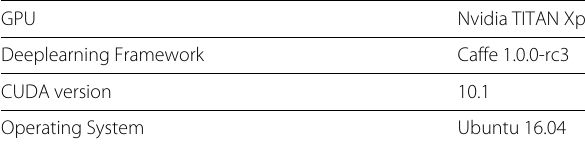
Table 3 Configuration of training environment